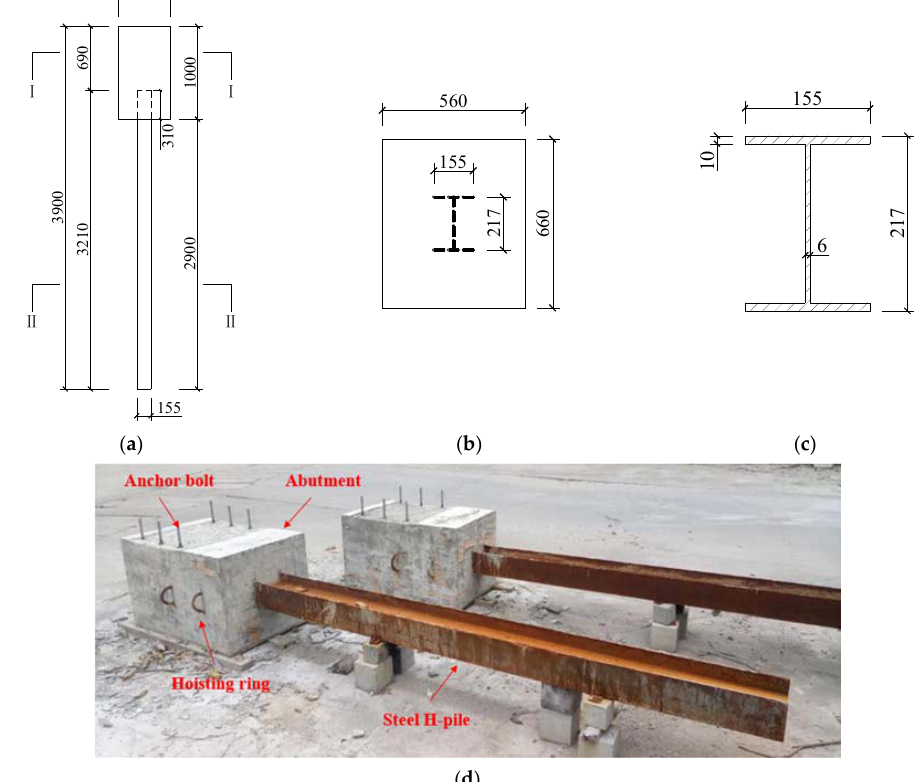
Figure 1. Test specimen dimensions (unit: mm). ( a ) Abutment ‐ pile specimen. ( b ) Section I ‐ I. ( c ) Section II ‐ II. ( d ) Photos of specimen after construction.